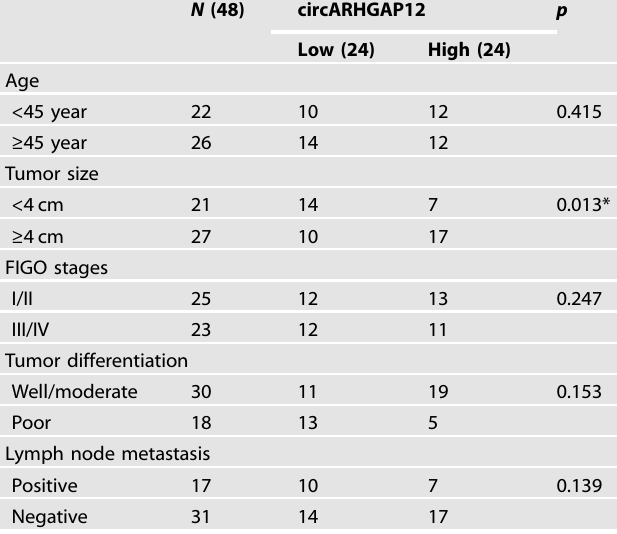
Table 1. The correlations between circARHGAP12 and cervical cancer patients ’ clinicopathological characteristics.